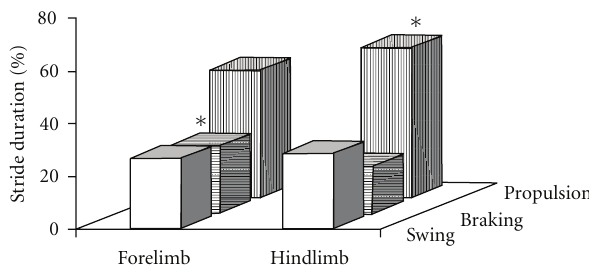
Figure 2: (a) The relative contributions of swing, braking, and propulsion to the stride duration of forelimbs and hindlimbs in 9- month-old F1B control hamsters walking at 16 cm/sec. ∗ P < . 05, forelimbs versus